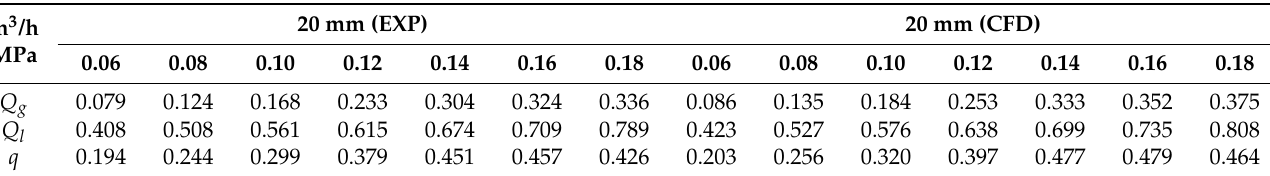
Table 1. Numerical calculation design and the results.